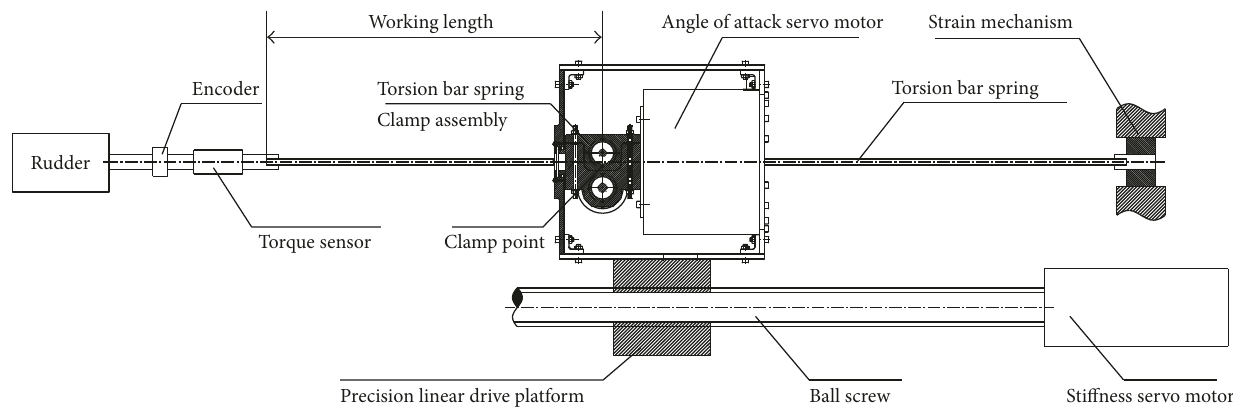
Figure 1: Structure of the variable sti ff ness loading